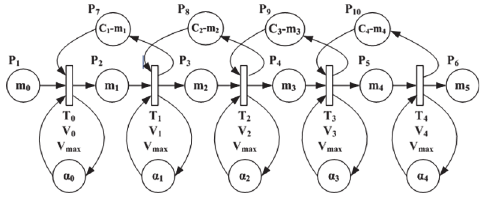
Fig 9. VCPN traffic